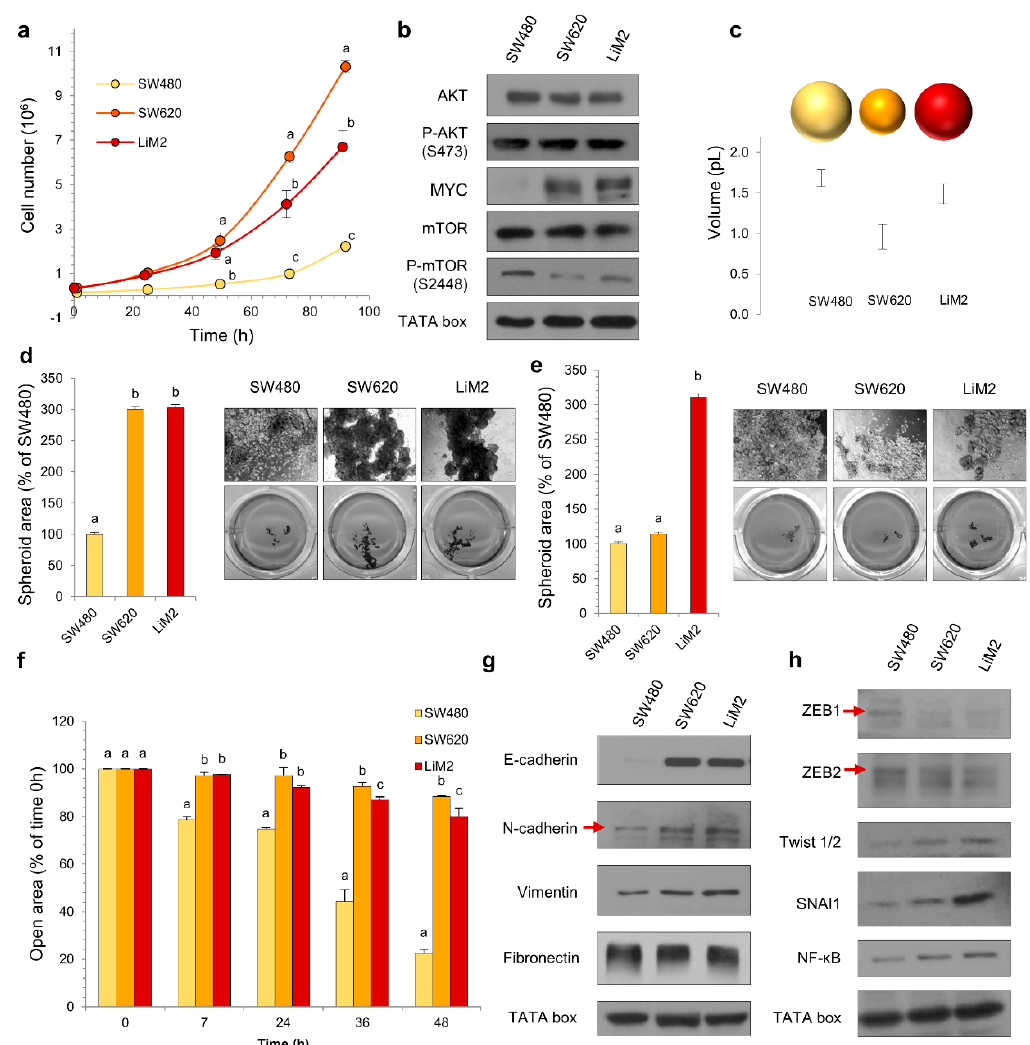
Figure 1. Characterisation of the metastatic phenotype. ( a ) Growth curve from 0 to 96 h incubation with DMEM 12.5 mM Glc and 4 mM Gln, 5% FBS and 1% S/P. ( b ) Protein levels of the main oncogenic signalling pathways tested by western blotting. TATA box was used as a loading control. ( c ) Cell volume measured by Scepter ® . ( d ) Spheroid formation assay and ( e ) secondary spheroid formation assay. Quantification of spheroid area in the left. Images of contrast-phase microscope (40×) in the right and scan (1×). ( f ) Migration area quantification from a wound healing assay. ( g ) and ( h ) Protein levels of EMT markers and related transcription factors tested by western blotting. a,b,c A one-way ANOVA and Scheffe’s test for multiple comparisons was performed for the factor “cell line”.